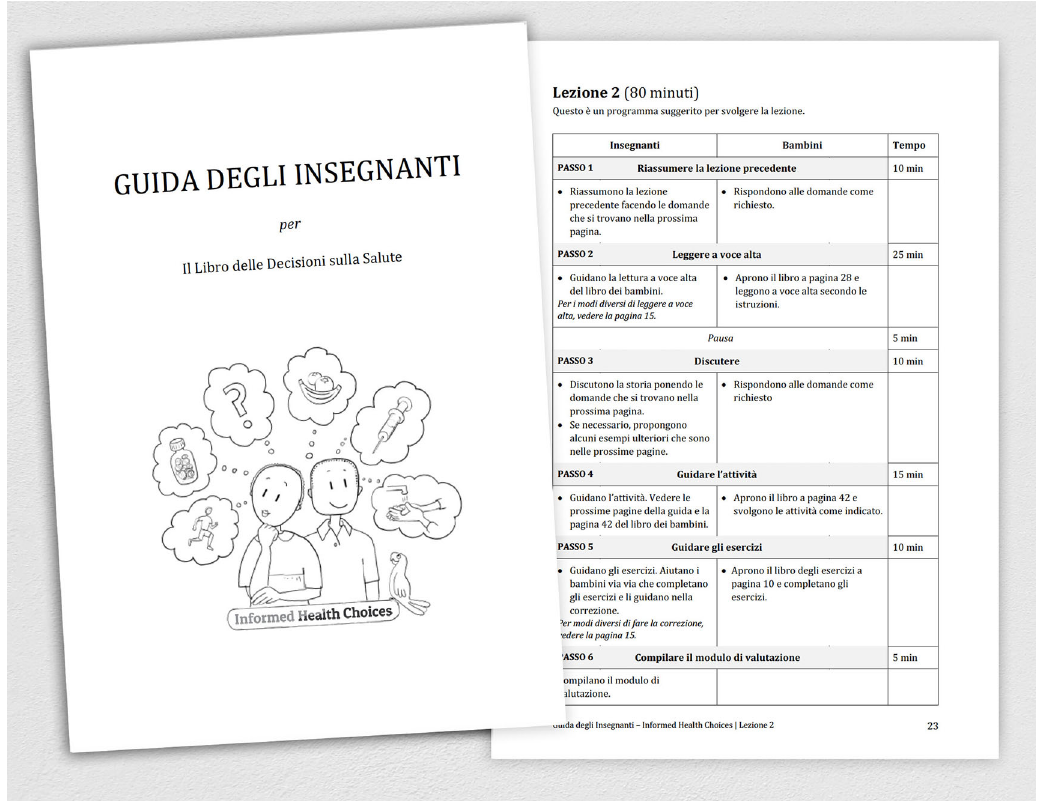
Figure 2. Italian translation of “ Teachers ’ Guide for The Health Choices Book ” , for primary school teachers.